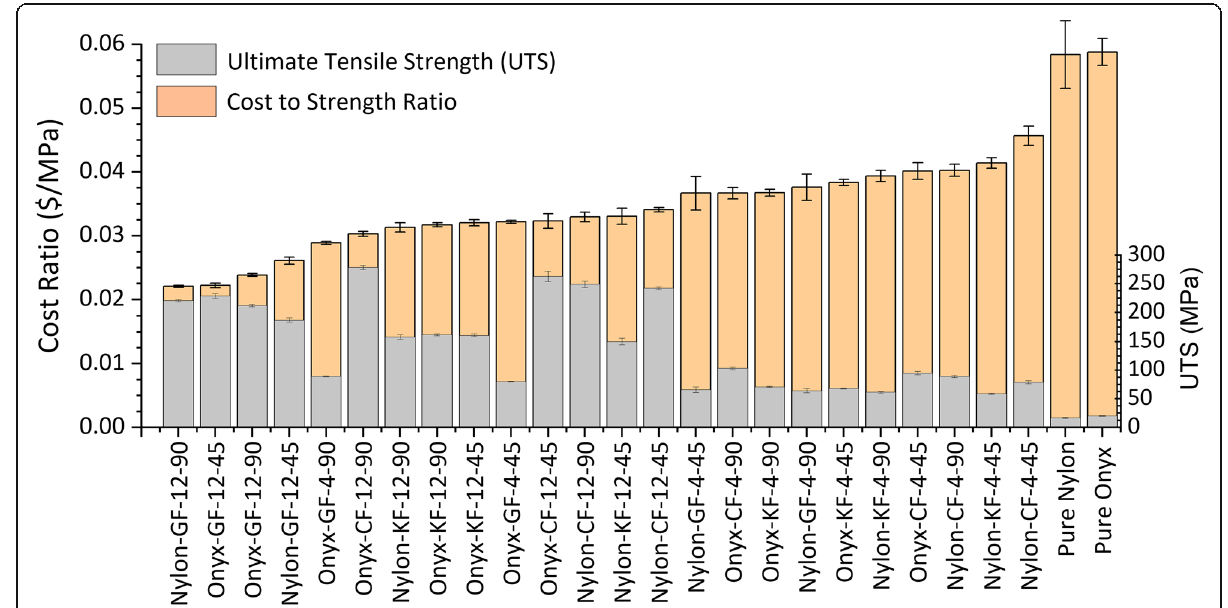
Fig. 9 Cost Ratio ($/MPa) and UTS for Composites and Un-reinforced Materials